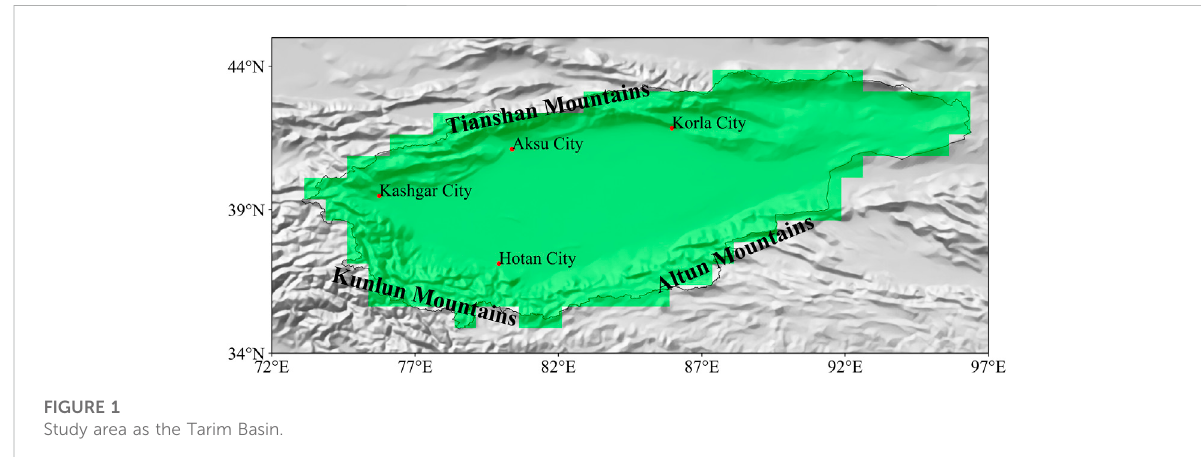
FIGURE 1 Study area as the Tarim